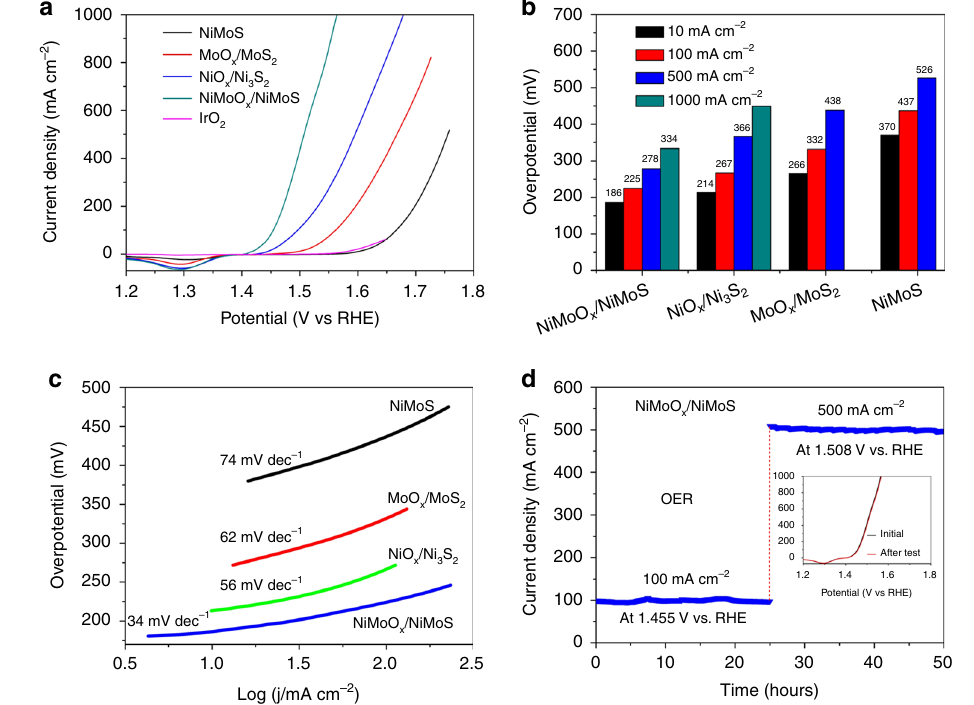
Fig. 6 OER catalytic performance. a OER polarization curves, b overpotentials at typical current densities, c Tafel slopes of NiMoS, MoO x /MoS 2 , NiO x / Ni 3 S 2 , and NiMoO x /NiMoS. d Time-dependent current density curves of NiMoO x /NiMoS at typical potentials. Inset: polarization curves of NiMoO x /NiMoS for the durability